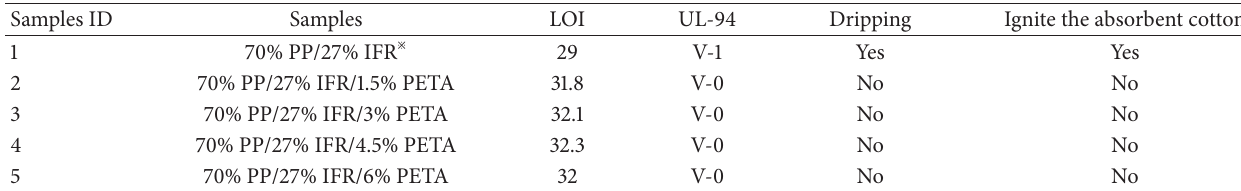
Table 1: LOI and UL-94 results of flame retardant PP